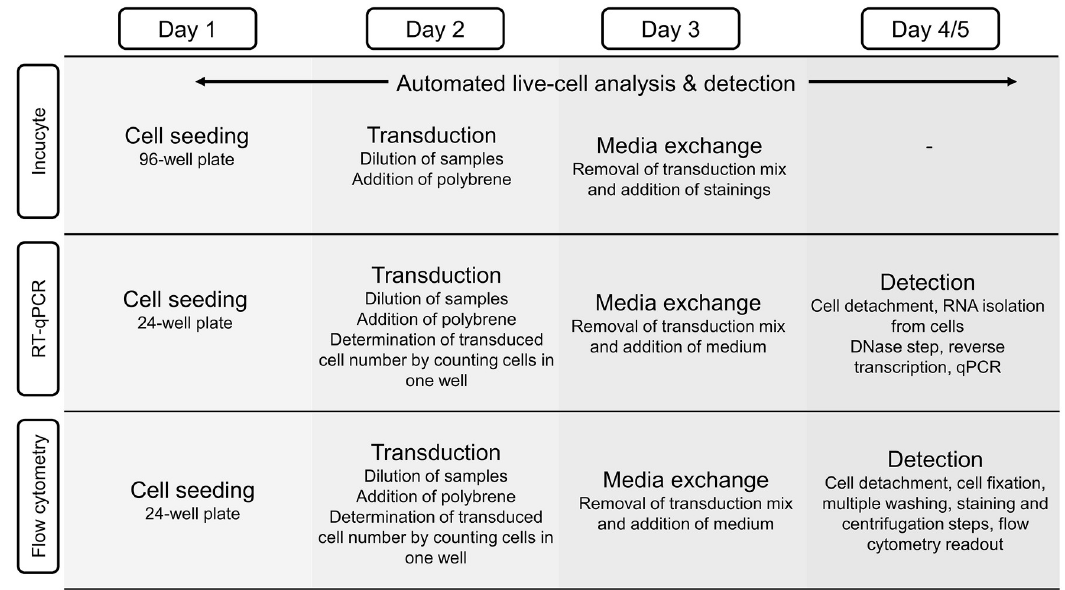
Fig 2. Workflow comparison of lentiviral vector (LV) infectious titer determination methods. One day after cell seeding, cells are transduced with LV and transduction enhancer; measurement of cell number may be required to determine the cell number at time of transduction. On the third day the transduction mix is removed and replaced by growth medium and the staining mixture for the Incucyte 1 method. While the Incucyte 1 -based assay continually detects transduced cells with no further action required, the flow cytometry and RT-qPCR based assays require intensive handling for the final (endpoint) readout on day 4 or 5.